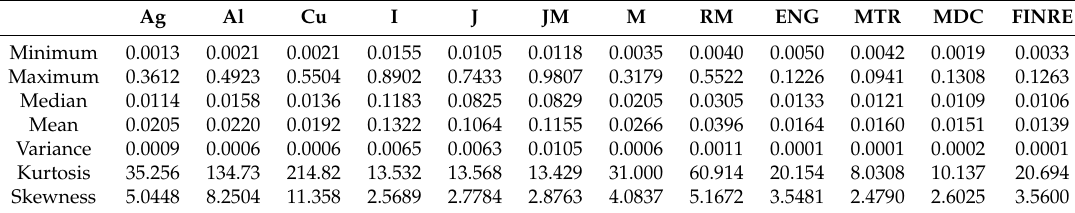
Table 2. Summary statistics of RBV for each product.